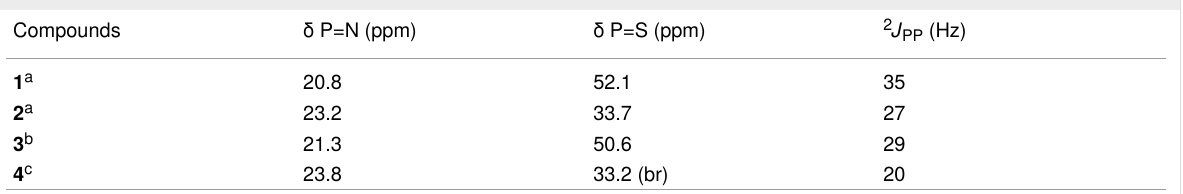
Table 1: Comparison of the 31 P { 1 H} NMR data for all the generated